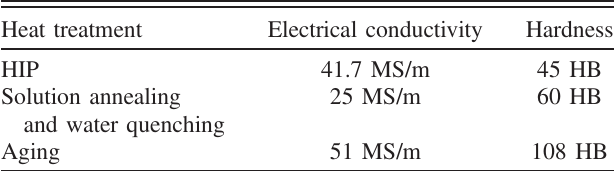
TABLE III. Electrical conductivity and Brinell hardness evo- lution with heat treatments after